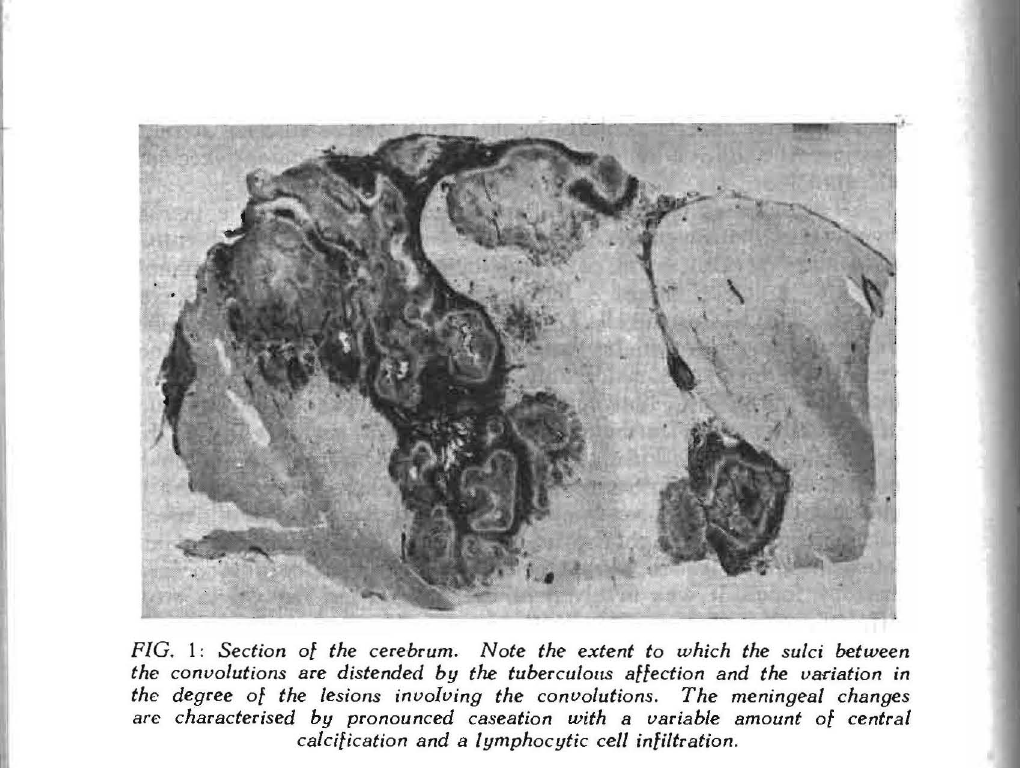
FIG. 1: Section of the cerebrum. Note the extent to which the sulci between the convolutions are distended by the tuberculous affection and the variation in the degree of the lesions involving the convolutions. The meningeal changes are characterised by pronounced caseation with a variable amount of central calcification and a lymphocytic cell infiltration.